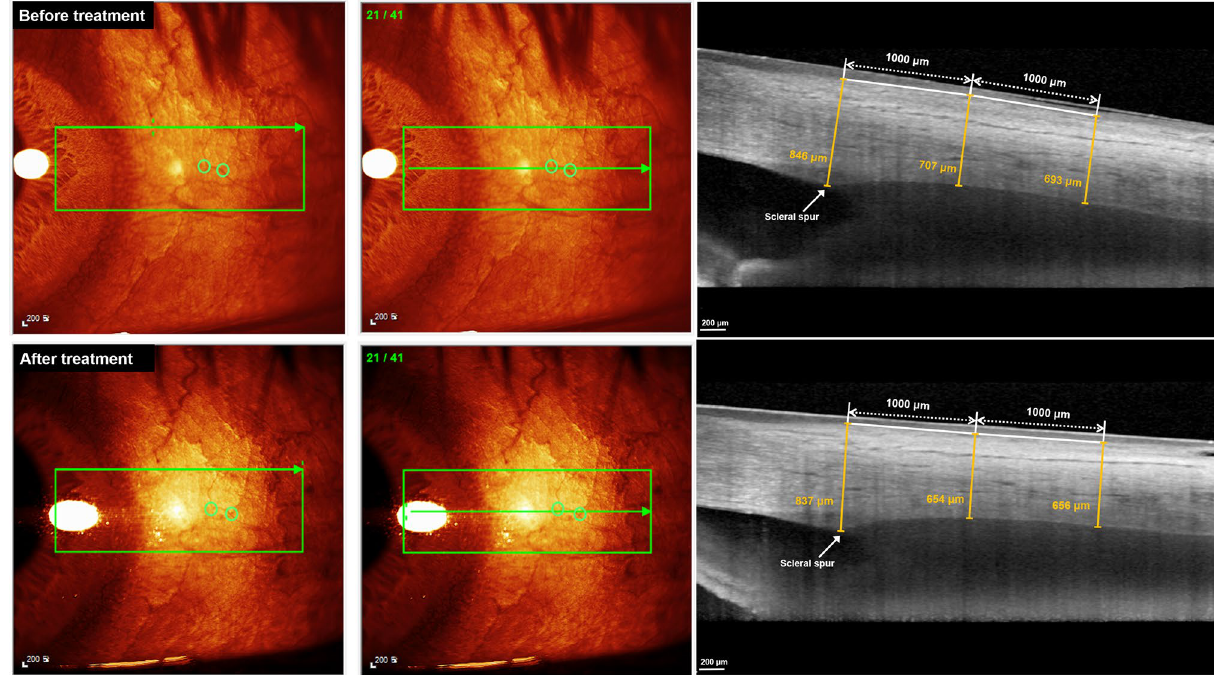
Figure 2. Enhanced Depth Imaging Optical Coherence Tomography B-Scans Before (Top) and After (Bottom) Administration of Topical Intraocular Pressure Lowering Agent. (Left, Middle) The conjunctival vessels were used as landmarks to compare the same B-scans before and after using the topical medications. (Right) The anterior scleral thicknesses were measured at the location of scleral spur, 1000 μm and 2000 μm posterior to the scleral